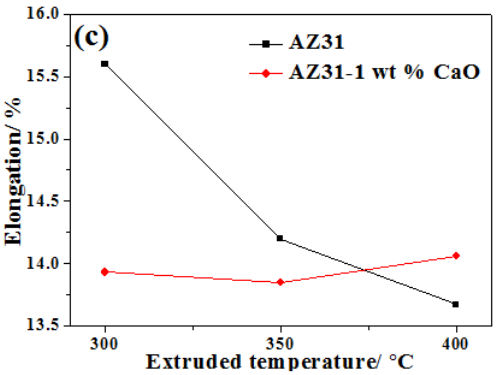
Figure 7. Tensile properties of AZ31 and AZ31-1%CaO alloys under different extrusion temperatures. ( a ) Ultimate tensile strength; ( b ) yield strength; and, ( c ) elongation.